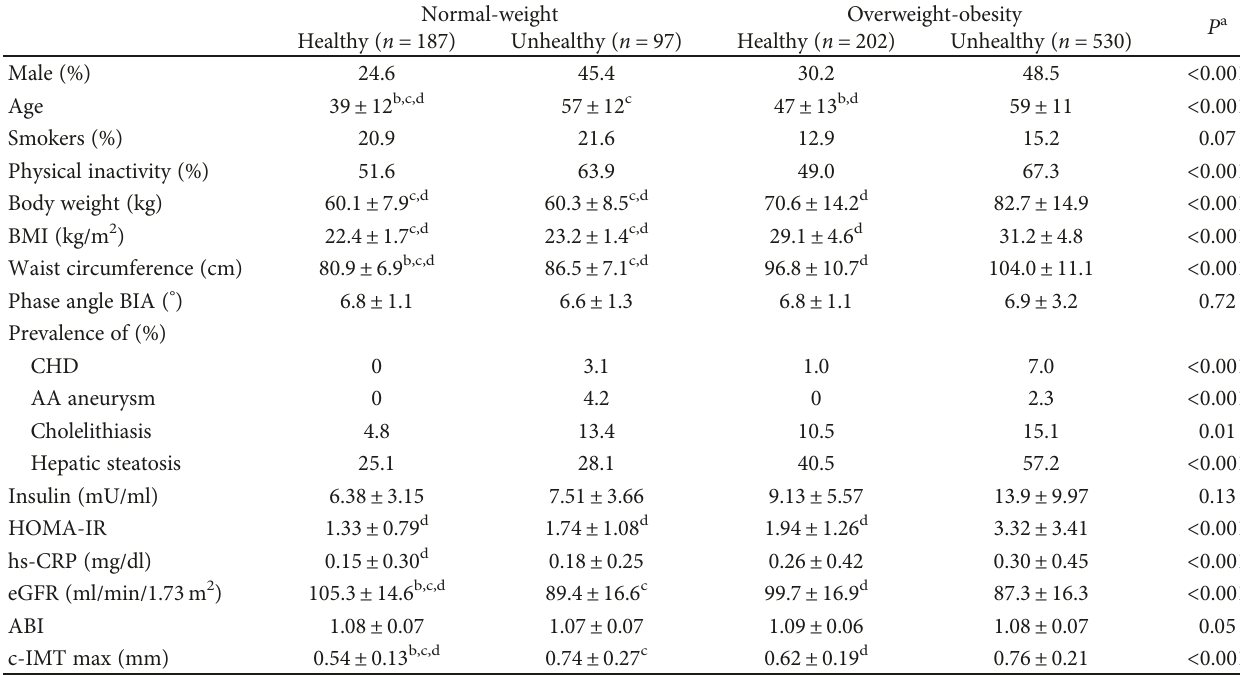
Table 4: Physical and biochemical characteristics of the cohort divided according to the presence of overweight-obesity and diabetes- prediabetes, hypertension, and hypertriglyceridemia or low HDL cholesterol (healthy=0-1 conditions; unhealthy =at least 2 conditions).